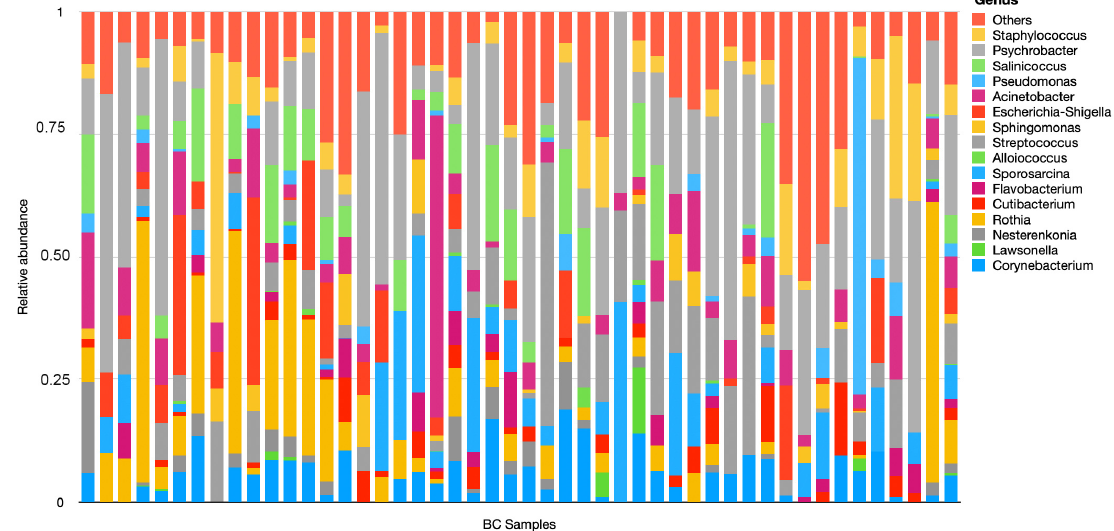
Figure 2. Relative microbial abundance at genus level in tumor tissues. BC Samples: breast cancer samples.